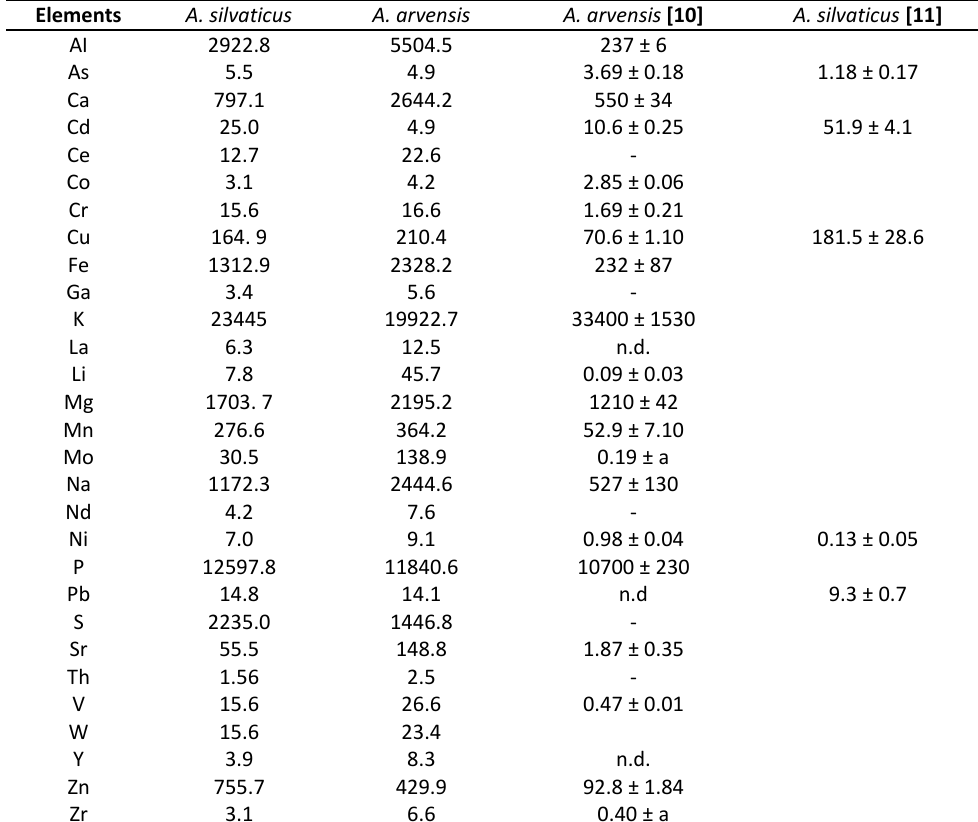
Table 2. Mineral contents (mg/kg, dry weight) of Agaricus